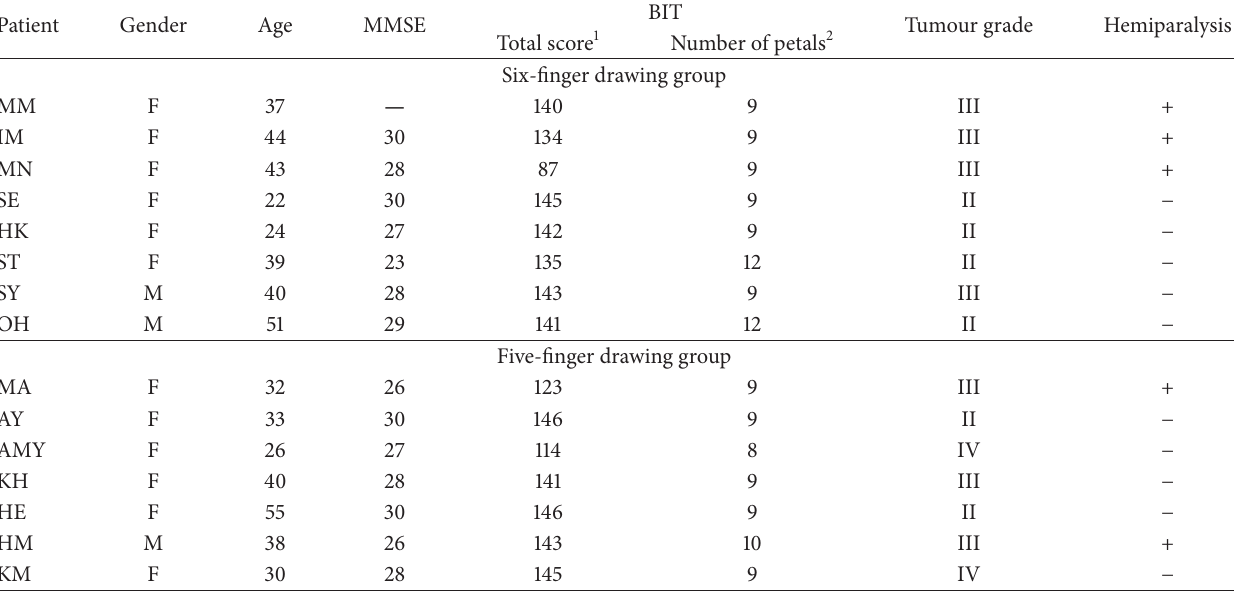
Table 1: Characteristics and neuropsychological results for patients in the present study.